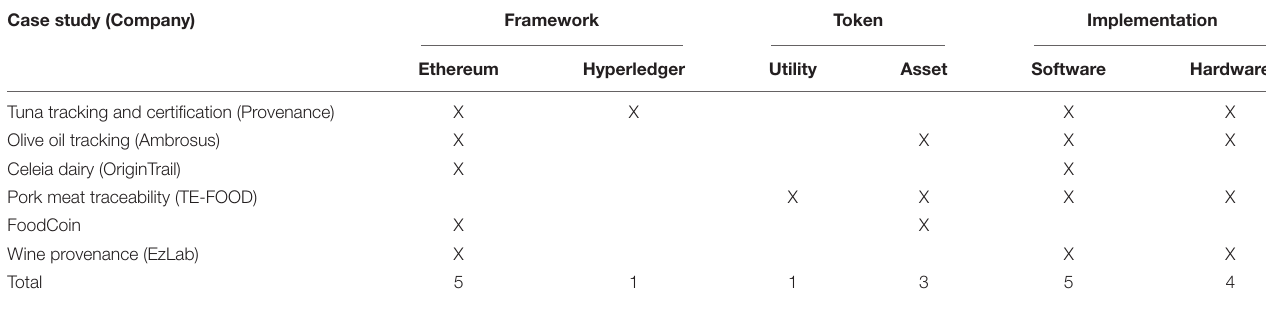
TABLE 3 | Company technical